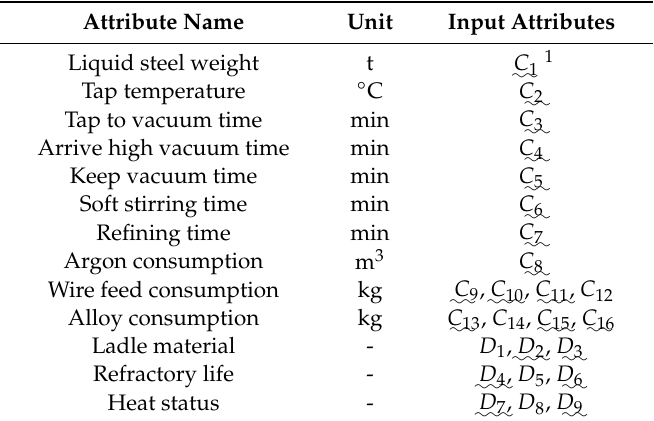
Table 1. List of candidate input attributes from VTD.